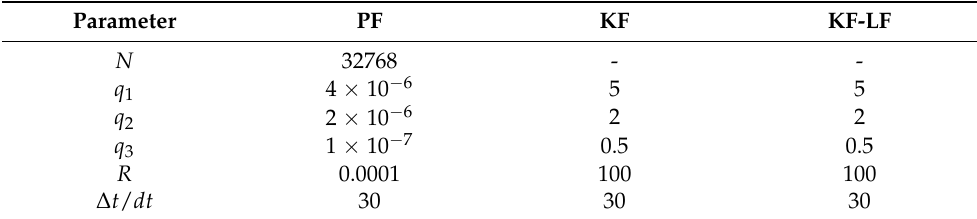
Table 3. Technical parameter